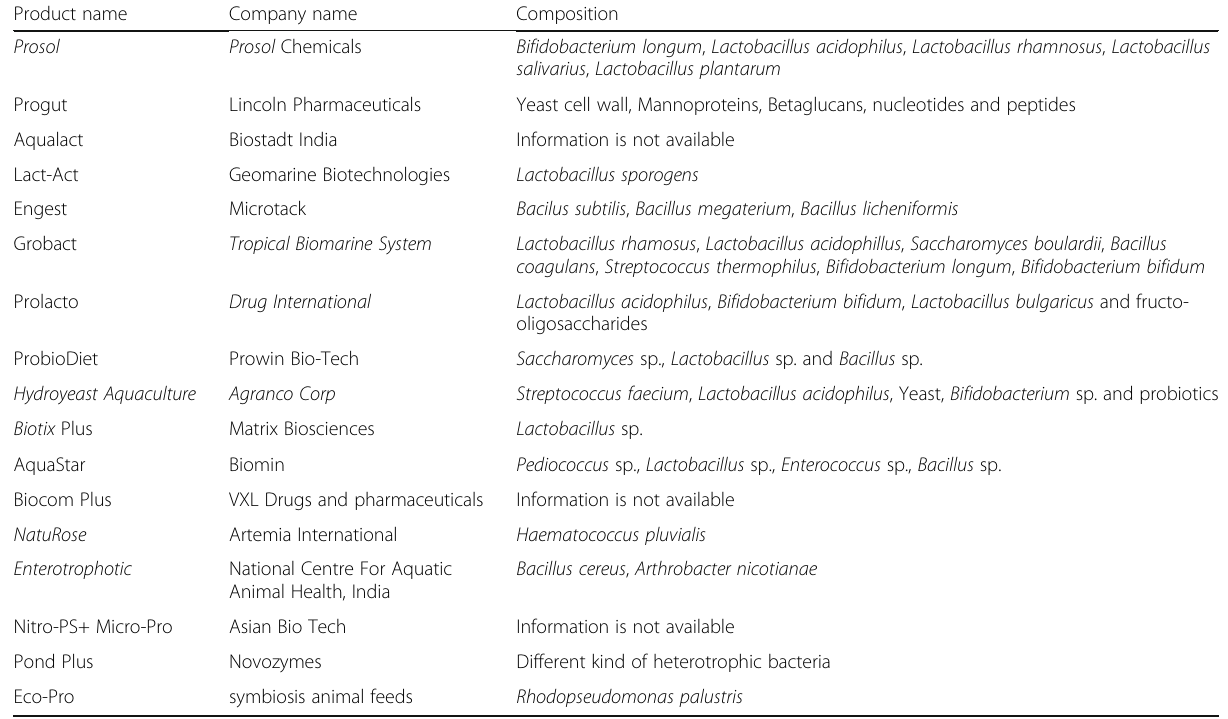
Table 3 Commercial probiotics for aquaculture available in the